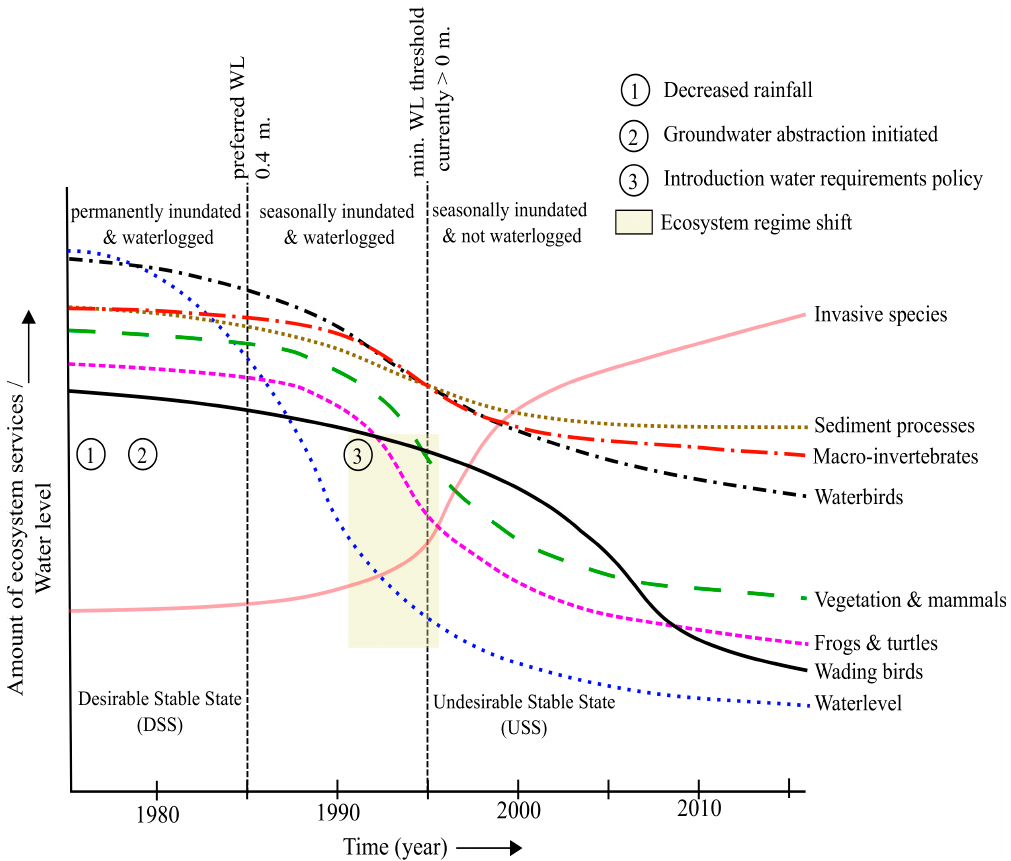
Figure 7. Ecosystem regime shift on the onset of dry periods with declining water levels (WL) and the change of conditions of ecological processes over time. Incremental management and policy compared to non-linear ecosystem responses over time are ineffective when sudden changes occur.